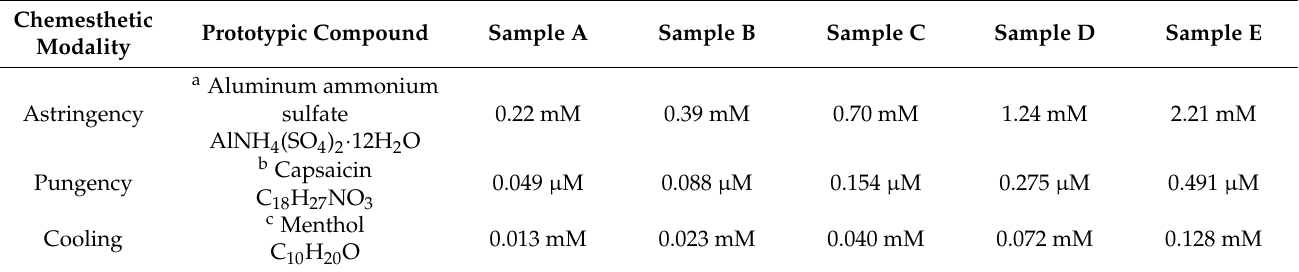
experiences using quarter logarithmic dilution series (Table 1) and one water sample as a zero-sample. Table 1. The sample series for chemesthetic modalities was created by using activating chemical compounds. Samples are listed from the lowest concentration to the highest (A–E). Every sample was evaluated in the same session and samples were